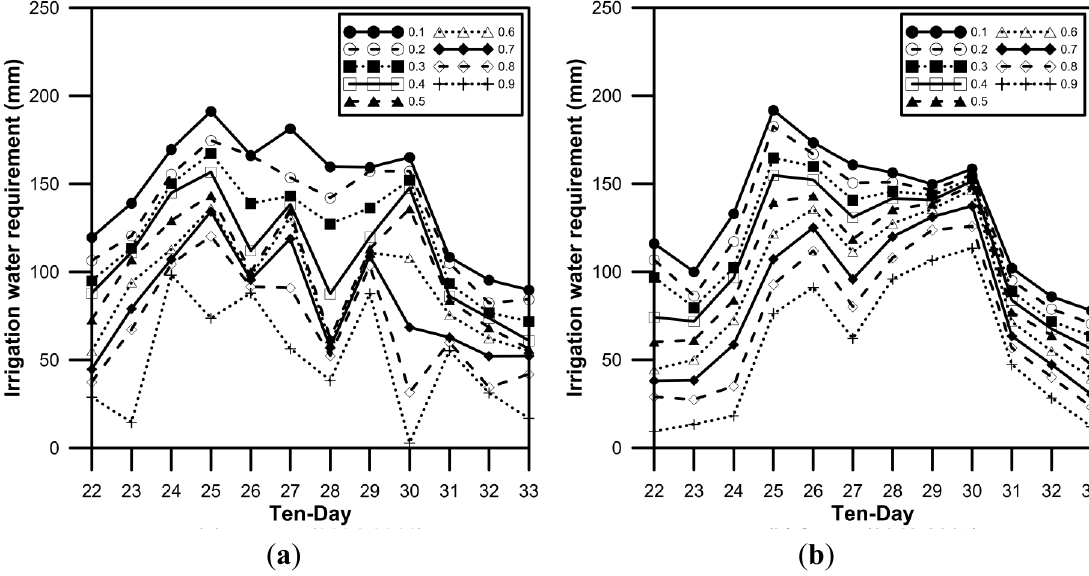
Figure 18. Exceedance probability distribution of irrigation water requirement at each ten-day during the second cropping season. ( a ) present (2004–2011); ( b ) future